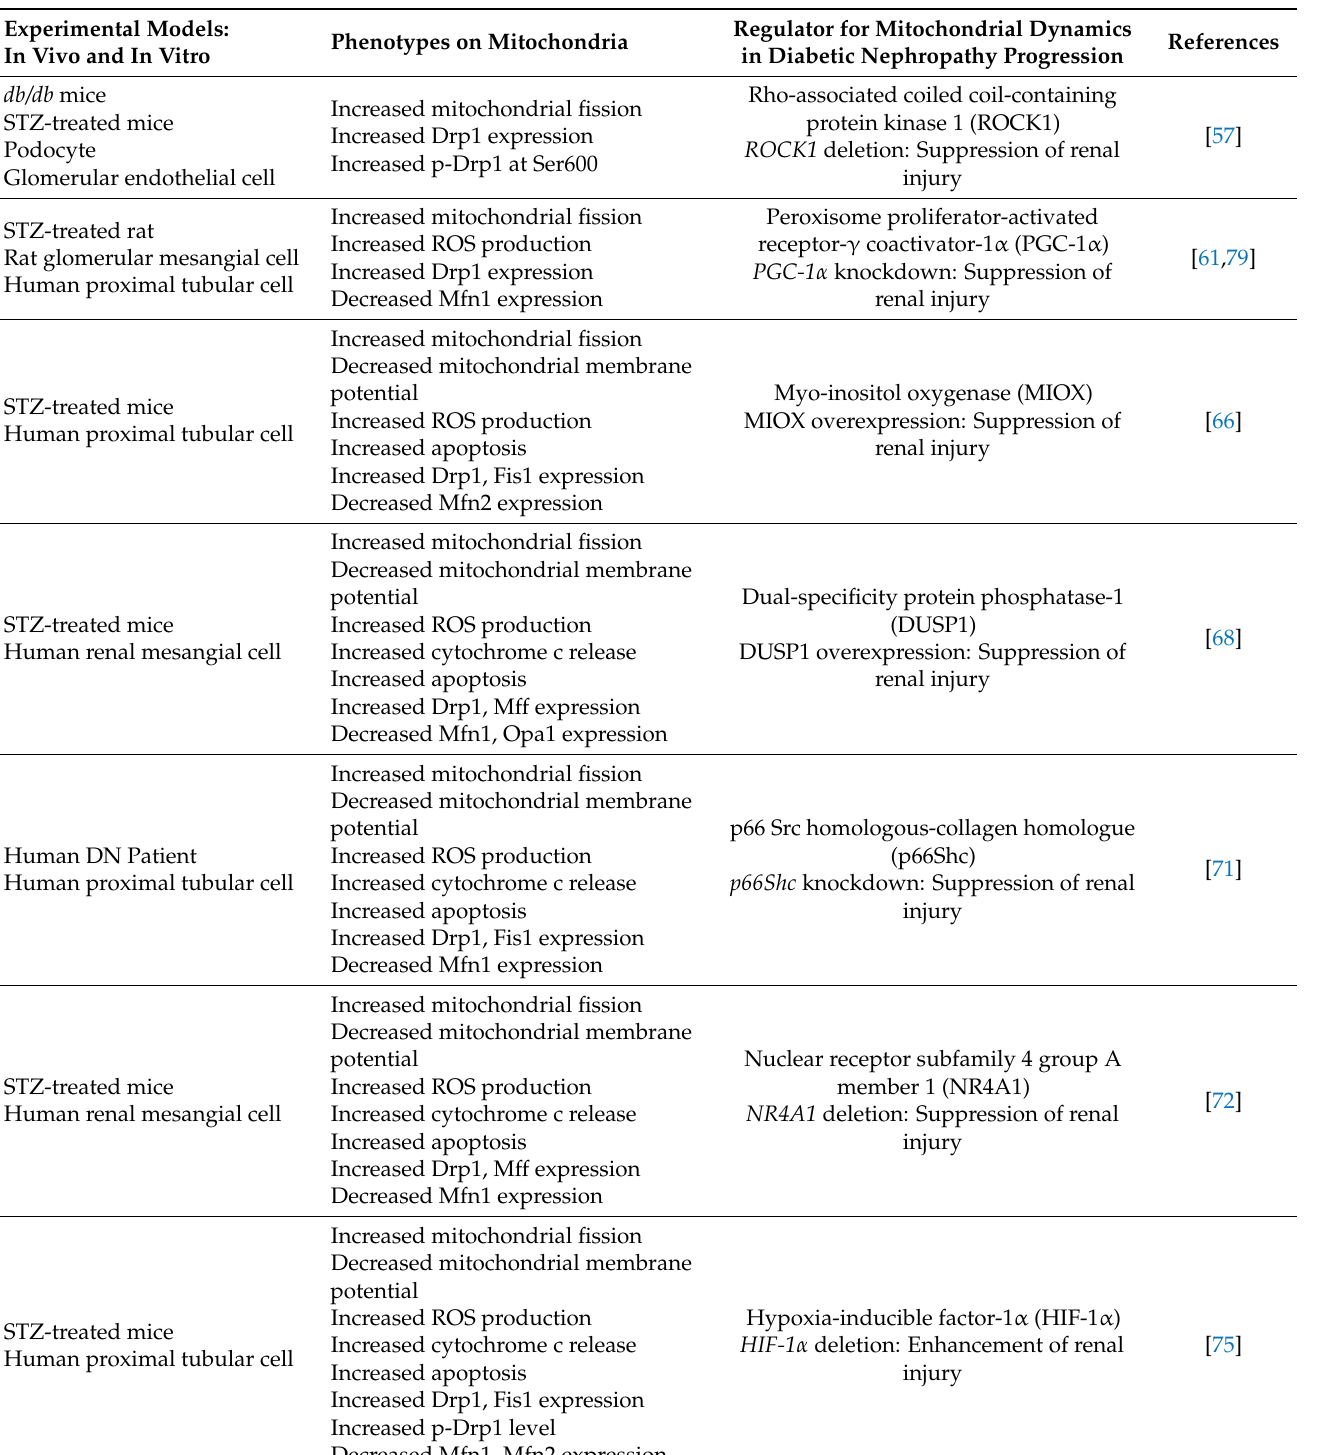
Table 1. Regulators that affect mitochondrial dynamics in various experimental models of diabetic nephropathy. Experimental